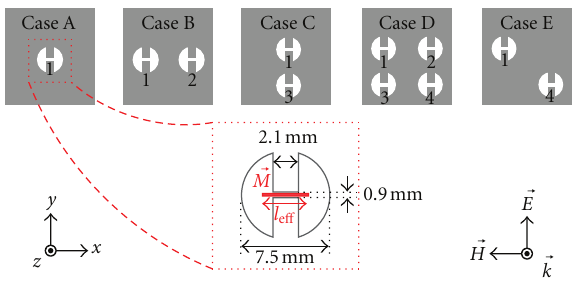
Figure 1: Ridged circular apertures perforated in an infinitesimally thin metal screen; (case A: single aperture; case B: collinear; case C: side-by-side; case D: 2-by-2; case E: